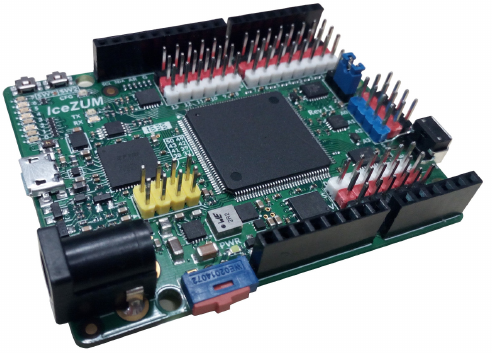
Figure 2. IceZum Alhambra FPGA